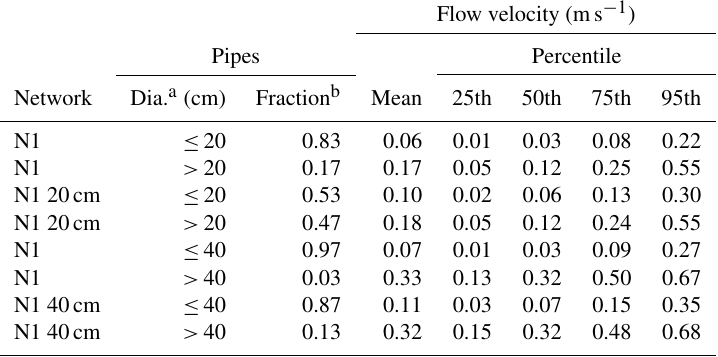
Table B2. Network N1 flow velocities, determined for the last 24h of a 168h simulation, using a 1h hydraulic time step.